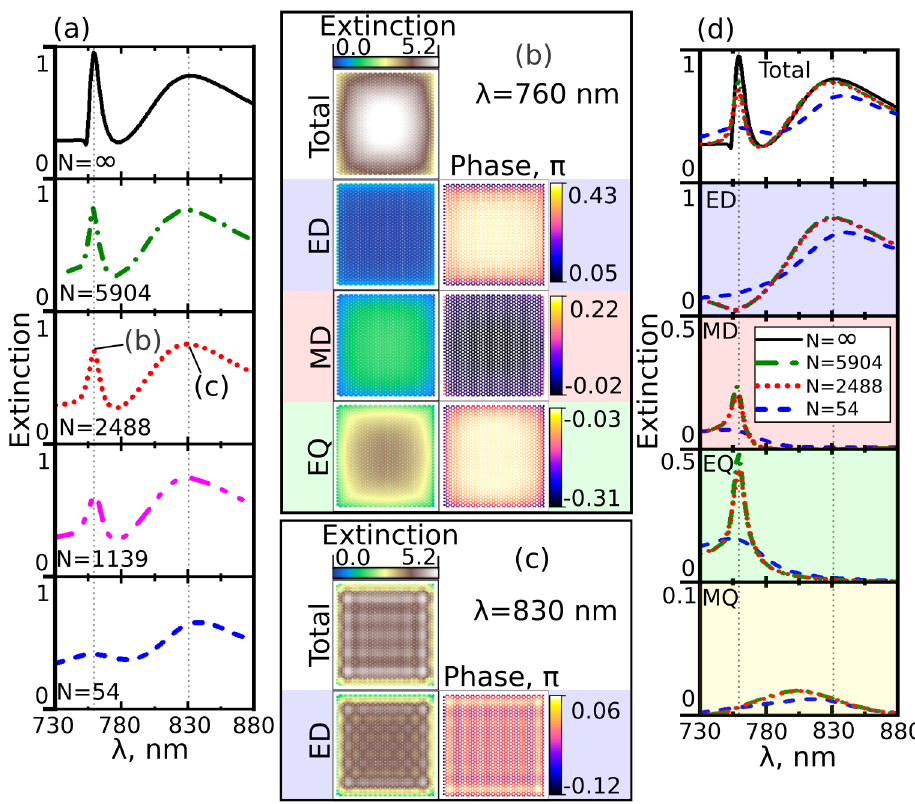
Figure 4. ( a ) Extinction spectra for honeycomb arrays of N spherical Au NPs with R Au = 120 nm and period (distance between NPs centers) h b = 600 nm. ( b , c ) Extinction efficiency per particle, corresponding phases of scattered wave and its decomposition for resonances at λ = 760 nm (ED, MD, EQ) and λ = 830 nm (ED) for N = 2488. ( d ) Total extinction spectra and the respective contributions of multipolar modes (ED, MD, EQ, MQ) for the arrays with different N , as labeled in the